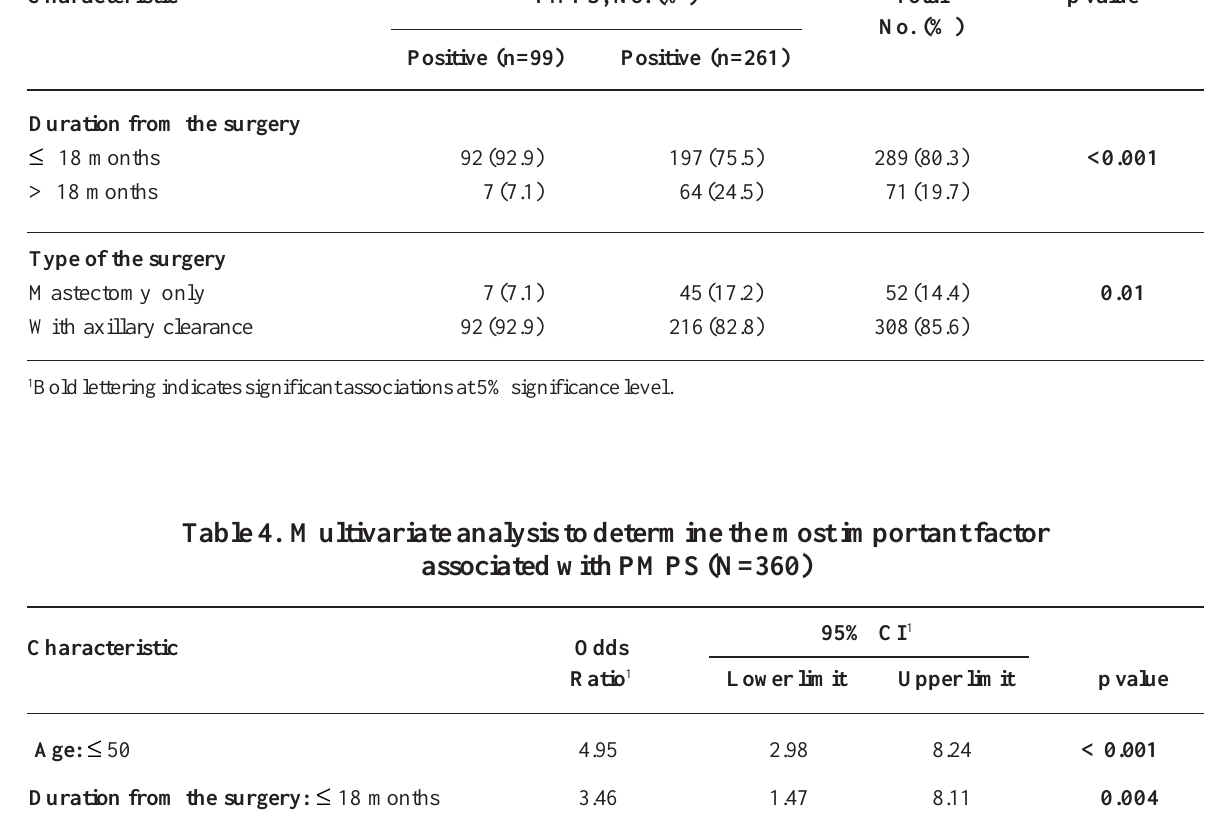
Table 3. Association of the duration and type of surgery with PMPS (N=360) Characteristic